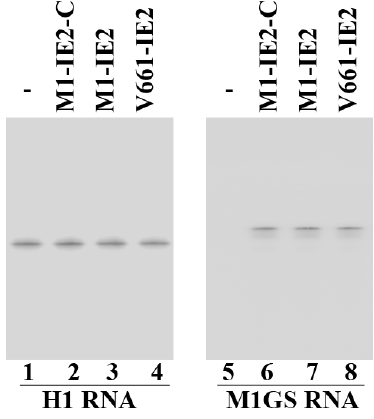
Figure 2. M1GS ribozymes expression with Northern blot analysis in parental U373MG cells (-, lanes 1 and 5) and cells with M1-IE2-C (lanes 2 and 6), M1-IE2 (lanes 3 and 7), and V661-IE2 (lanes 4 and 8). H1 RNA control (lanes